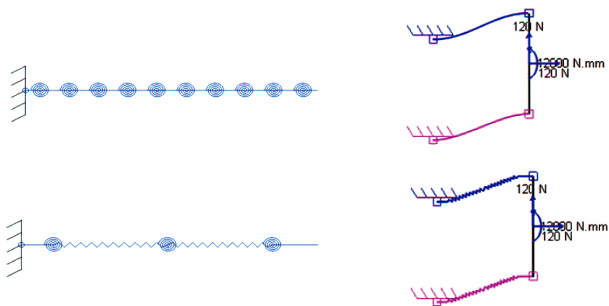
Figure 9. The two PRB models used (left) and the software output of the deformation of the flexure mechanism